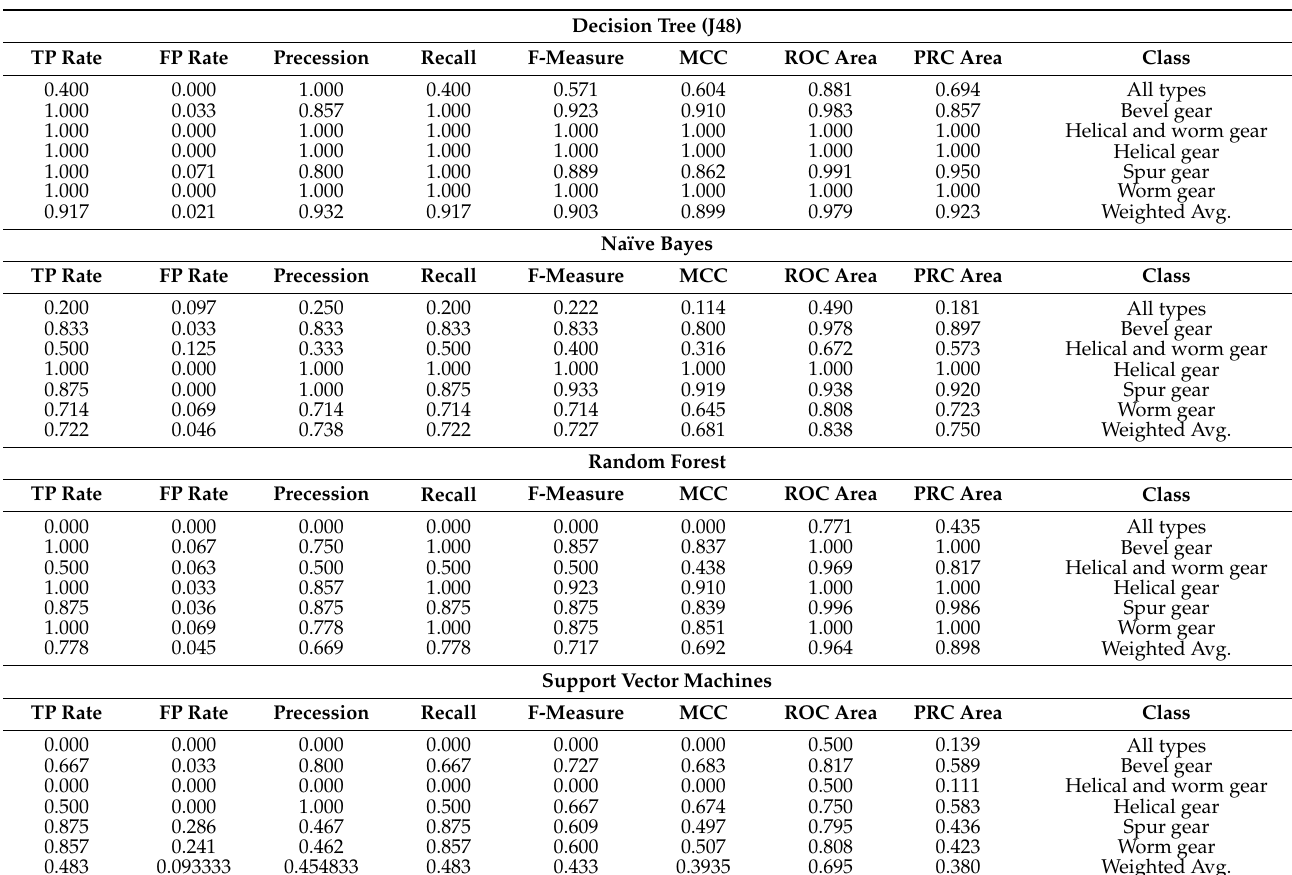
Table 4. Various performance measures for machine-learning algorithms Decision Tree (J48), Naïve Bayes, Random Forest, and Support Vector